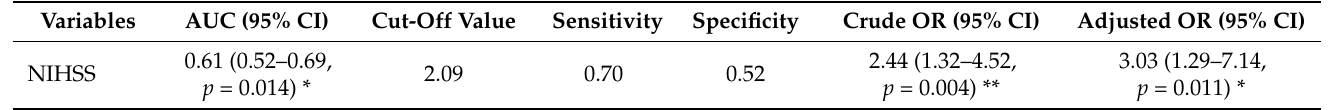
Table 5. Logistic regression analysis of the associations between the optimal NLR cut-offs and the indicators of stroke severity and functional